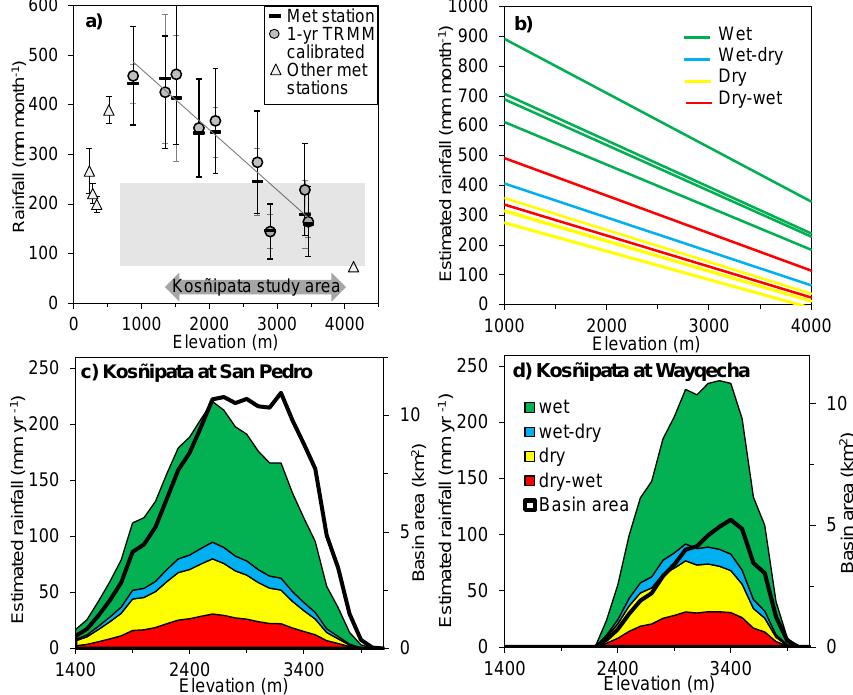
Figure 2. (a) Mean monthly rainfall data for the nine meteorological stations in the Kosñipata catchment study area (from ∼ 900 to ∼ 3500ma.s.l.) (dark dashes and light error bars) and estimated mean monthly rainfall (grey circles and dark error bars) covering the months of the 1-year study period (February 2010 to January 2011) determined using the linear regression equations for each meteorological station derived from Tropical Rainfall Measuring Mission (TRMM) data (Table S8). The grey line is the linear fit with elevation for the estimated mean monthly rainfall (mmmonth − 1 =− 0.1216 ± 0.0187 × elevation + 593.16 ± 44.94, R 2 = 0.86; P = 0.0003). The error bars are 2 × standard error of monthly data. Mean monthly rainfall for five meteorological stations outside of the study area but within the larger Madre de Dios Basin is also shown as triangles (Rapp and Silman, 2012). The shaded box shows the TRMM 3B43 v7a monthly mean rainfall for the 1-year study period with 2 × standard error. Elevation range is shown for the 34.5km × 34.5km TRMM tile. The altitudinal range of the study area is represented by the dark grey bar with arrows between 1350 and 4000ma.s.l. (b) Linear regressions of estimated catchment-wide rainfall by month from February 2010 to January 2011, colour-coded by season. The distribution of annual rainfall with elevation by season for the Kosñipata River is shown for the San Pedro (SP) gauging station (c) and the Wayqecha (WQ) gauging station (d) at 100m intervals using the monthly linear regressions (b) incorporating the correction for wind-induced rainfall loss (Table